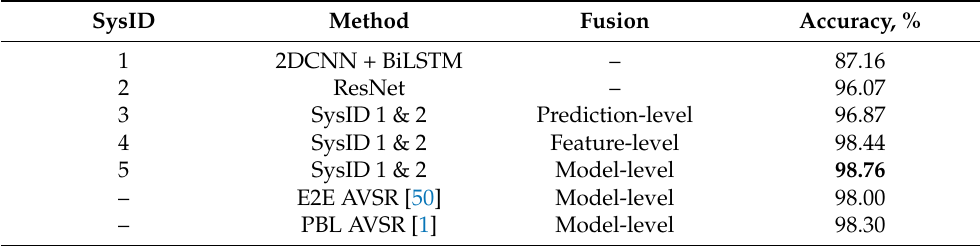
Table 9. The results obtained by the proposed methods of modality fusion in comparison with state-of-the-art results. SysID Method Fusion Accuracy, % 1 2DCNN + BiLSTM – 87.16 2 ResNet – 96.07 SysID 1 & 2 Prediction-level